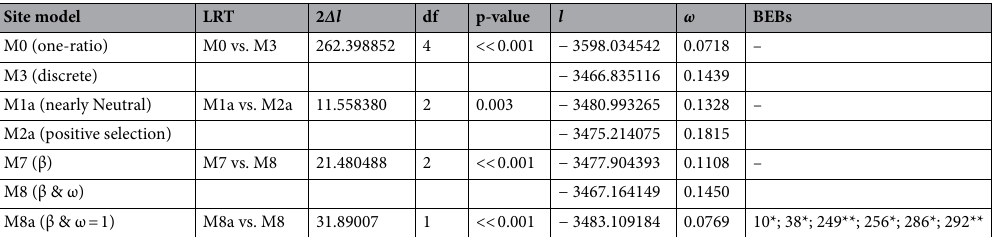
Table 1. Likelihood ratio tests of seven different site models performed on 296 amino acids (888 bp) of the HSP 40 kDa, including 29 of the 32 unique alleles (A11, A12 and A18 were excluded from the analysis, as they only occurred in specimens affected by hybridization/introgression). Underlying phylogeny is based on the ITS1 (532 bp) of B. calyciflorus s.s., B. fernandoi , B. angularis , B. diversicornis and B. rubens . For each likelihood ratio test (LRT), we provide log likelihood ( l ) values of the compared tests (2∆ l ), degrees of freedom (df), p-values, estimated average ratio of non-synonymous vs. synonymous substitutions (ω), and the sites inferred to be under positive selection by Bayes Empirical Bayes (BEB) analysis, labeled with an * for a posterior probability of > 95% and ** for > 99%.